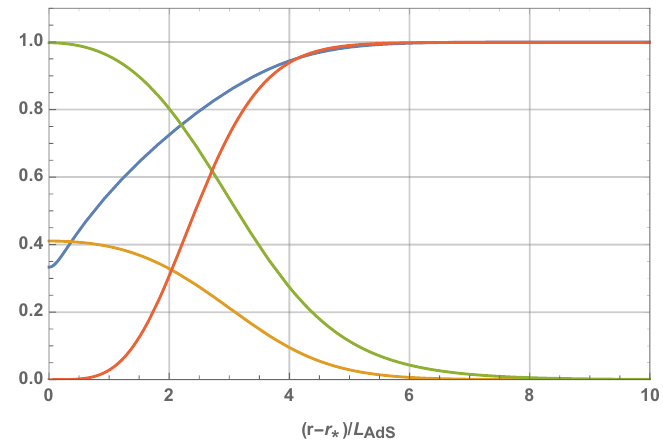
Figure 2. An example of a numerical solution to the BPS equations (3.12)–(3.14). The solution was obtained by shooting from the IR with (cid:17) 0 = 1 = 3 and other fields as in (3.17). The blue curve is (cid:17) , the yellow one is 300( z + ~ z ) , the green one (~ z (cid:0) z ) = 2 , and the red one is g e 2 A (cid:0) gr = 2